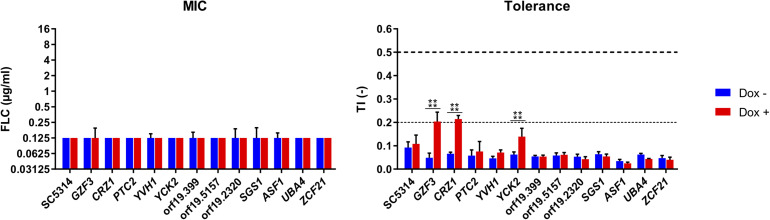
Susceptibility profiles of selected Tet-inducible strains in the presence Dox. Susceptibility profiles were performed at pH 6, in a range of FLC concentrations (0–16 μg/ml), in the presence (Dox+) or absence (Dox–) of doxycycline at 100 μg/ml and complemented with 1 mM FeCl3. FLC susceptibility was presented by their modal MIC value (left panel) and TIs at 8 μg/ml FLC (right panel). Standard deviations of the MIC values were calculated based on the mean MIC of each sample. The horizontal dashed line represents the lower threshold of tolerance (TI = 0.2) and the limit of susceptibility (TI = 0.5) as defined by EUCAST. Each bar is representative of biological triplicates. Statistical significance was determined using Sidak’s multiple comparison tests (Two-way ANOVA, Confidence interval = 95 %). P-values: (****) ≤ 0.0001.